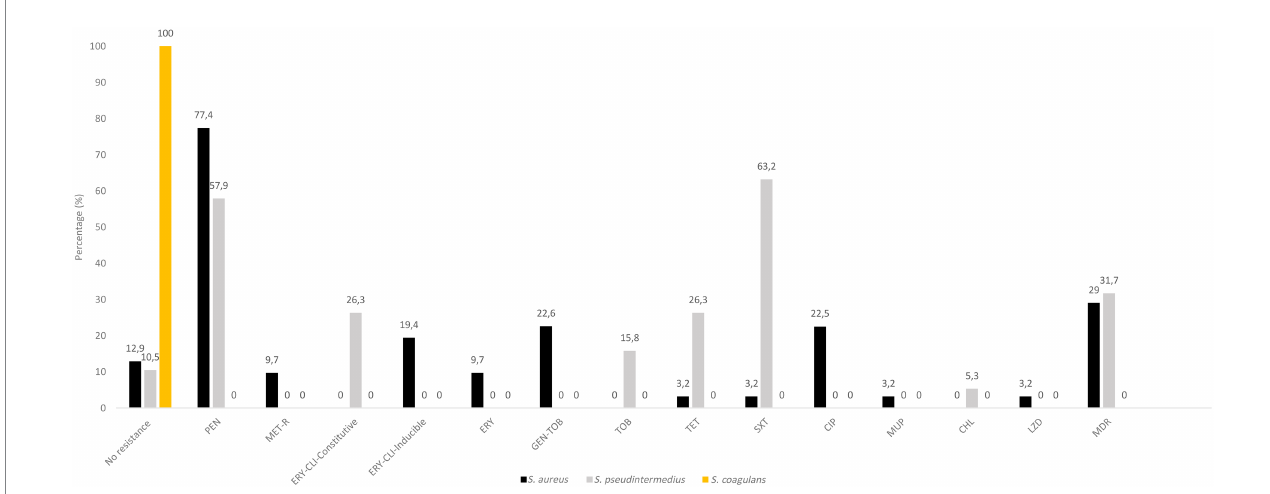
FIGURE 2 Antimicrobial resistance rates in S. aureus , S. pseudintermedius and S. coagulans isolates. Percentages were based on the collection of CoPS (31 S. aureus , 19 S. pseudintermedius and 2 S. coagulans ) obtained of different samples or those of the same sample but with different species and/or AMR phenotype. CHL, chloramphenicol; CLI, clindamycin; CIP, ciprofloxacin; ERY, erythromycin; GEN, gentamicin; MET-R, methicillin-resistant; MDR, multidrug resistance (resistance to three or more classes of antibiotics); PEN, penicillin; SXT, sulfamethoxazole/trimethoprim; TET, tetracycline, TOB,